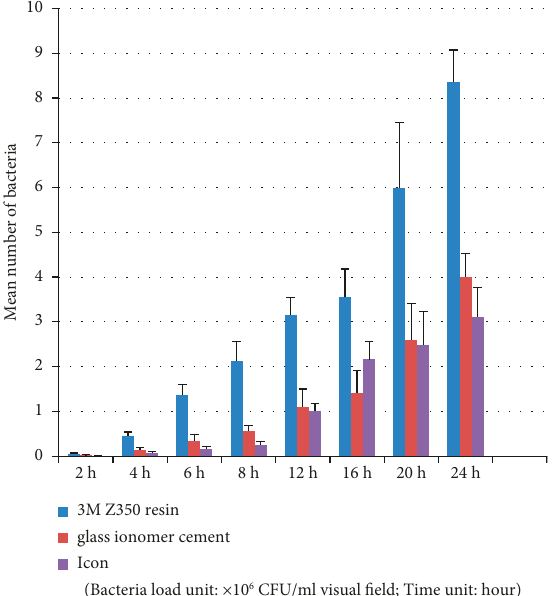
Figure 1: Streptococcus mutans group (plate colony counting).